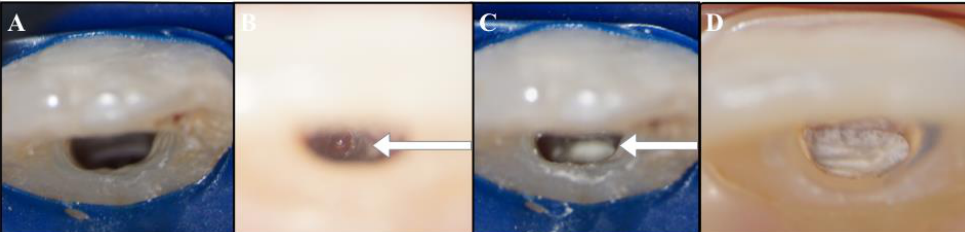
Figure 2. ( A ) Standard access cavity of tooth #2.1. ( B ) Identification of the wide opening of the apical portion of the coronal fragment of tooth #2.1 (arrowed). ( C ) Apical barrier of Portland cement (arrowed). ( D ) Complete obturation of the canal with the cement.